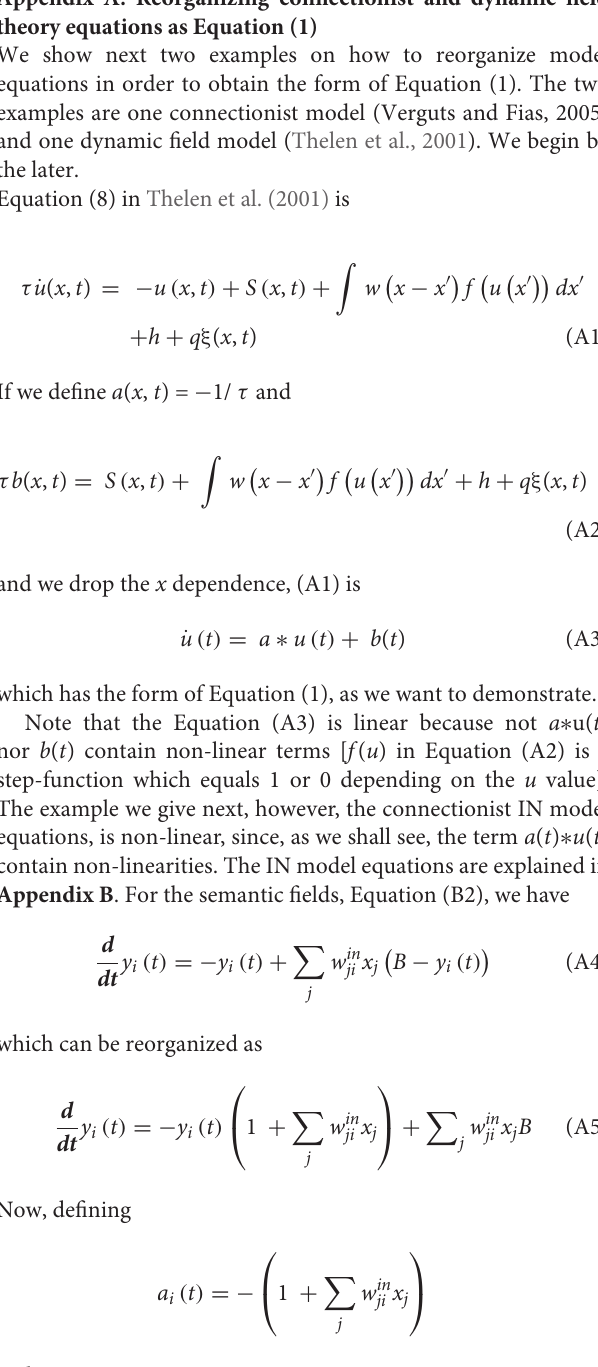
TABLE A1 | Coefficients a ( t ) and b ( t ) for each field in the IN model equations. (Equation)